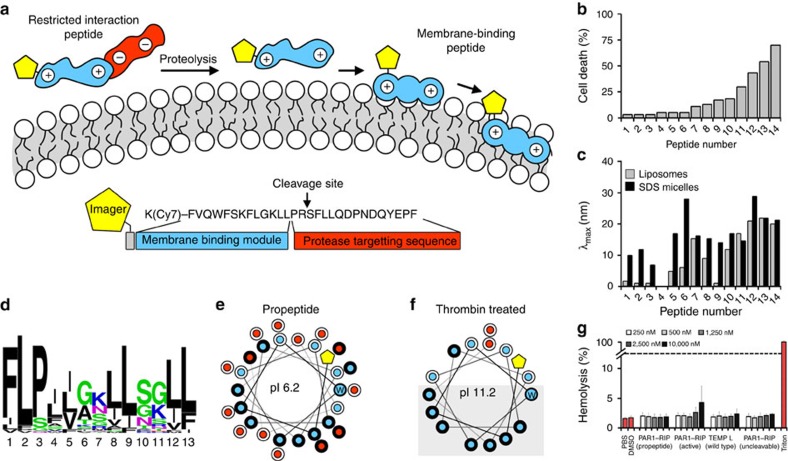
Mechanism underlying RIP technology.(a) RIP pro-peptides exist in a disordered state in solution with little affinity for phospholipid surfaces owing to the presence of the exosite-targeting sequence (red) and imaging agent (yellow) at the termini of the membrane-binding segment (blue). Following proteolysis, the membrane-binding segment is released and capable of interacting with cellular membranes whereupon they undergo conformational change and insertion. (b) Fourteen antimicrobial peptides (AMPs) were synthesized lacking their conventional post-translational modifications while including the Pro–Arg sequence that would be leftover after proteolysis by thrombin. The peptides were found to have various limited degrees of cellular toxicity. (c) Toxicity of these initial peptides weakly correlated with incorporation into PC liposomes or SDS micelles suggesting a variety of AMP mechanisms could be used in the RIP strategy and with different toxicities. (d) Temporin L (peptide 12 in (b) and (c)) in PAR1–RIP belongs to a large peptide family enabling its optimization when coupled to different imaging groups and targeting sequences. (e,f) Helical wheel diagram of the activated form of the peptide highlights the amphiphobic nature of the peptide. Colouring as in (a) with hydrophobic residues in black and hydrophilic residues in white. In contrast, the PAR1–RIP masks this helix with hydrophilic residues that also create an acidic pI for the peptide. (g) The resulting Cy7–PAR1–RIP probe selected for NIR imaging shows good haemocompatibility towards human erythrocytes in both active and pro-peptide form. Data are mean±s.d. of three biological replicates.